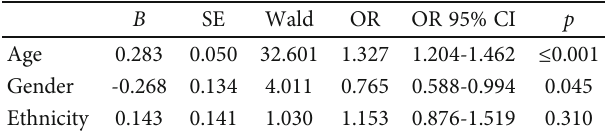
Figure 1: Refractive error detection rate in di ff erent subjects. (a) – (c) Visual acuity of students of di ff erent ages (a), genders (b), and ethnic groups (c). (d) – (f) The severity of myopia in students of di ff erent ages (d), genders (e), and ethnic groups (f). Table 2: Multivariate logistics regression analysis for the prediction of the factors in fl uencing